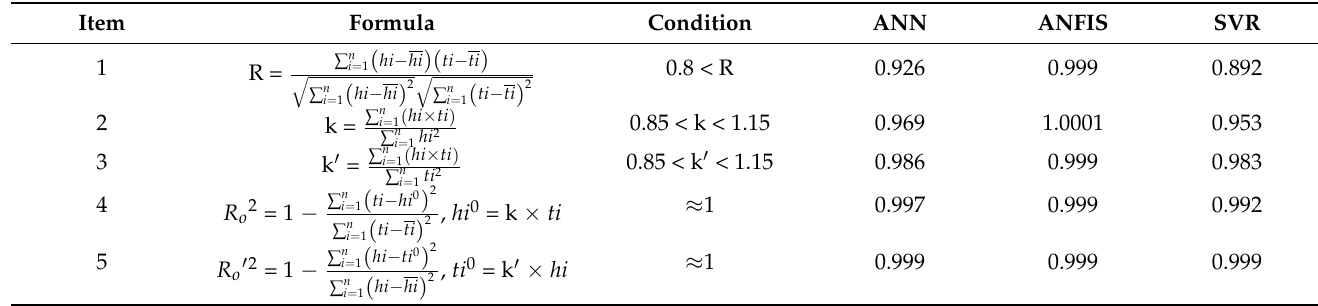
Table 4. The validation and performance of each model.